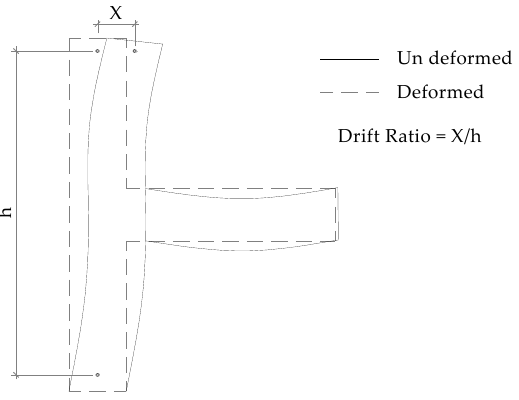
Figure 9. Drift ratio calculation as per ACI 374.1-05 [29].